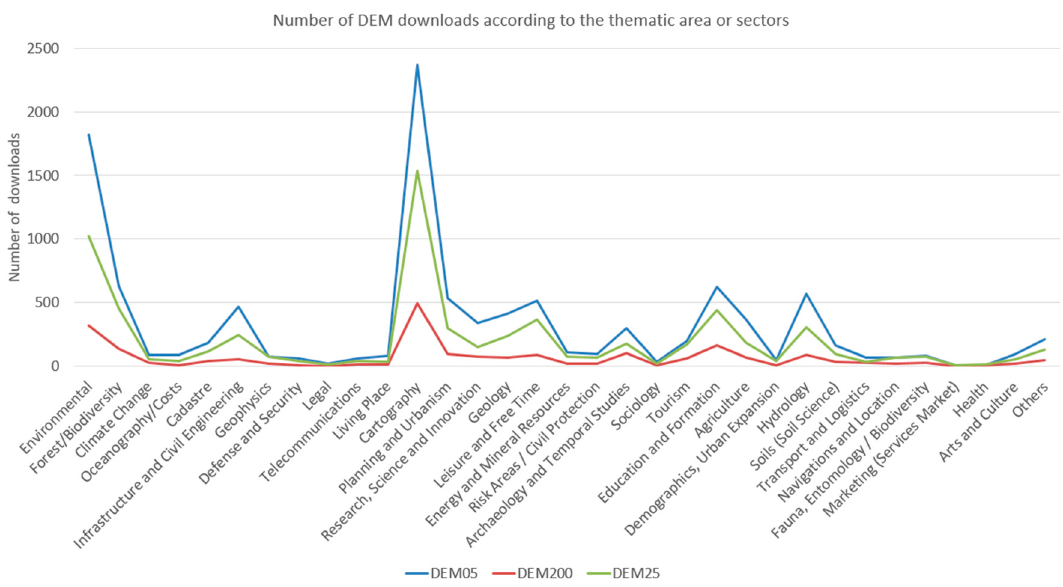
Figure 9. Number of Digital Elevation Model (DEM) downloads according to the Thematic Area.